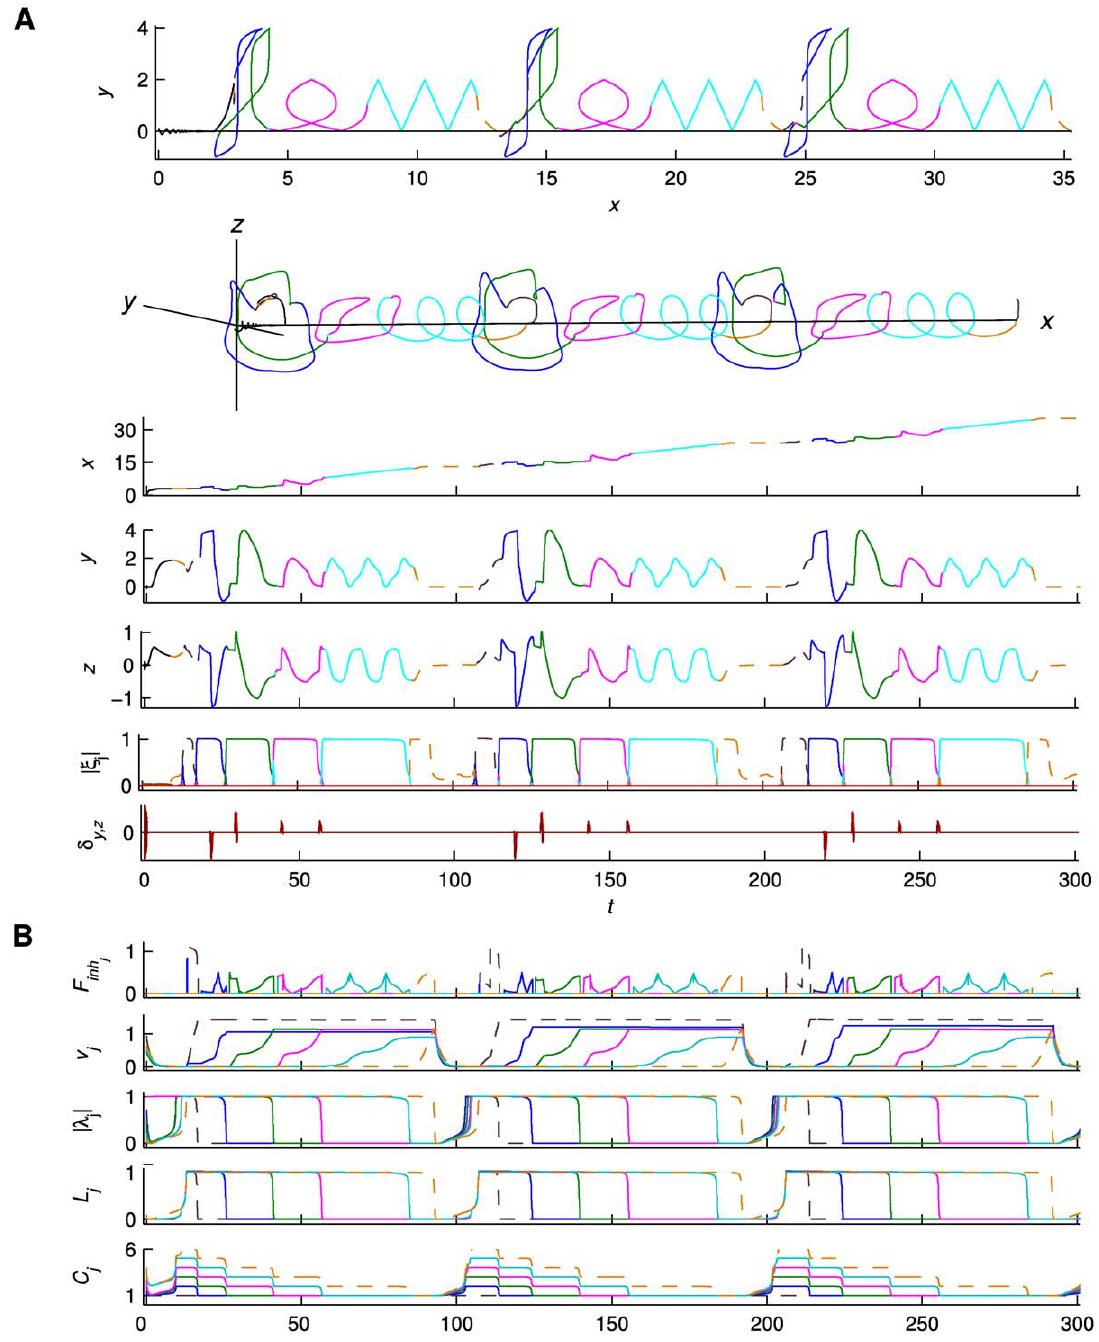
Figure 4. Simulation of the functional architecture generating the word ‘ flow ’. Panel A shows the generation of the word ‘ flow ’ and the operational signals involved. The word is repetitively generated after a short transient (black solid line). Four principle functional modes are used, one for each character (associated with solid blue, green, magenta and cyan lines, respectively), plus two auxiliary ones at the sequence’s beginning and end (dotted dark and light brown lines, respectively). From top to bottom: three repetitions of the word in the handwriting workspace (the plane x - y ), the output trajectory in the 3-dimensional functional phase space spanned by state variables x , y and z , followed by their time series, and the time series of the slow (WTA competition coefficients {| j j |}) and the instantaneous ( d y,z ‘kicks’, light and dark red, respectively) operational signals. The { j j } of the modes that do not participate in the word always have a value close to zero (red line). Panel B shows the feedback loop from the output dynamics to the slow sequential one. From top to bottom: time series of the inhibitory feedback functions F j inh , the slow feedback integrating variables v j , the absolute values of the (fast) ‘ switching ’ variables l j , and the WTA competition parameters C j and L j . These quantities vary on the time scale of a whole word (except for F j inh that varies at the time scale of a movement cycle), even if they also contain fast changes during their evolution. The parameter values for this simulation were as follows: noise standard deviation was s = 0.001, while k jinh = [6,12,5,5,2.67,6] and k jexc = [12,11,10,9,8,7] for each mode in the sequence, respectively (only these parameters that have to be manually set prior to a simulation). The initial conditions for the functional mode dynamics were x 0 = 0, y 0 = 0.1, and z 0 = 2 0.1, while those of { n j }, { l j } and { j j } where chosen randomly from a uniform distribution in the interval [0,1] for { n j } and { l j }, and [0,1/ K ] for { j j